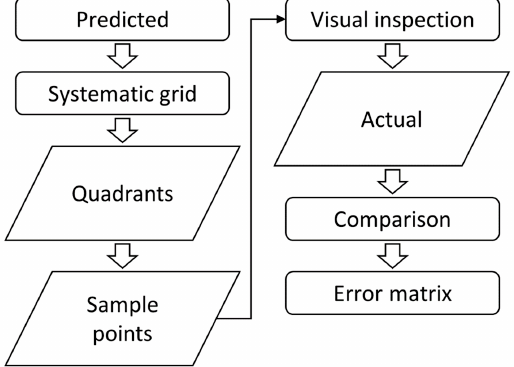
Figure 3. Workflow illustrating the forest patch validation